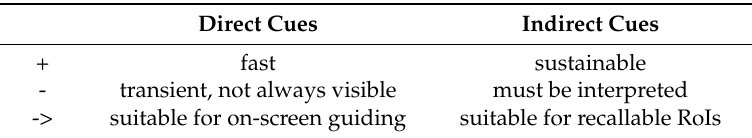
Table 7. Advantages and disadvantages of world-referenced and screen-referenced methods. The third row indicates for which requirements the methods are suitable.